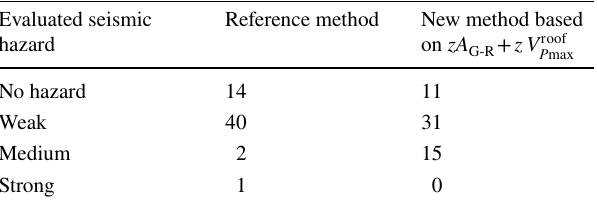
Table 7 Conformity assessment results for the reference method and the new seismic hazard evaluation method for the mined longwall 02Aw in coal seam 510 Evaluated seismic